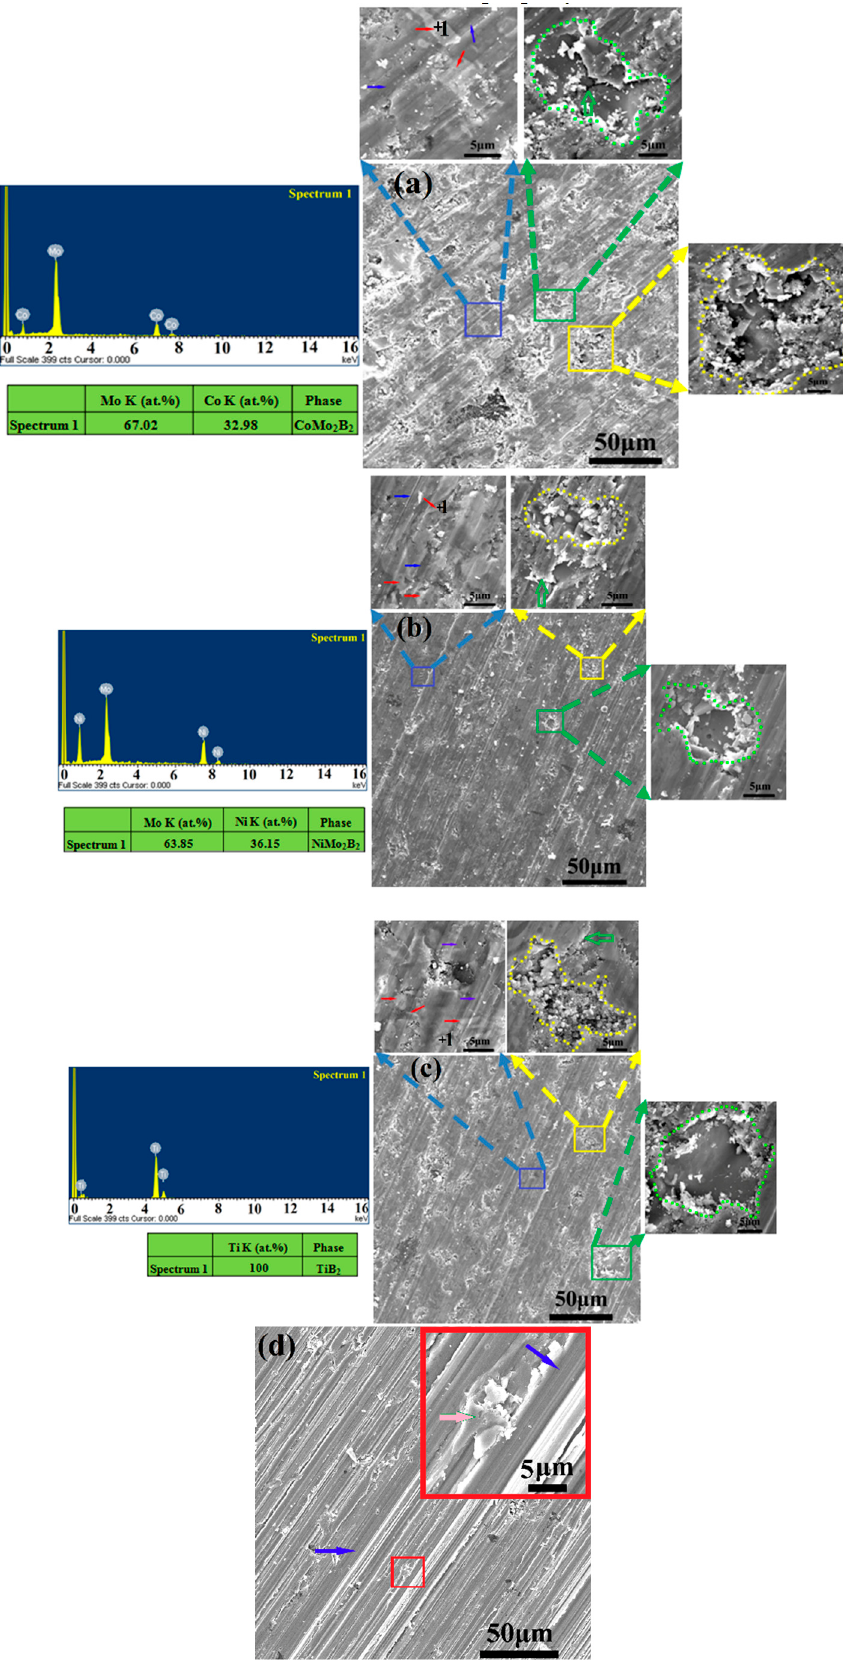
Figure 17. Worn tracks of the boride-based coatings: ( a ) MoB/CoCr, ( b ) MoB/NiCr, ( c )TiB/CoCr, and ( d ) 316L stainless steel.